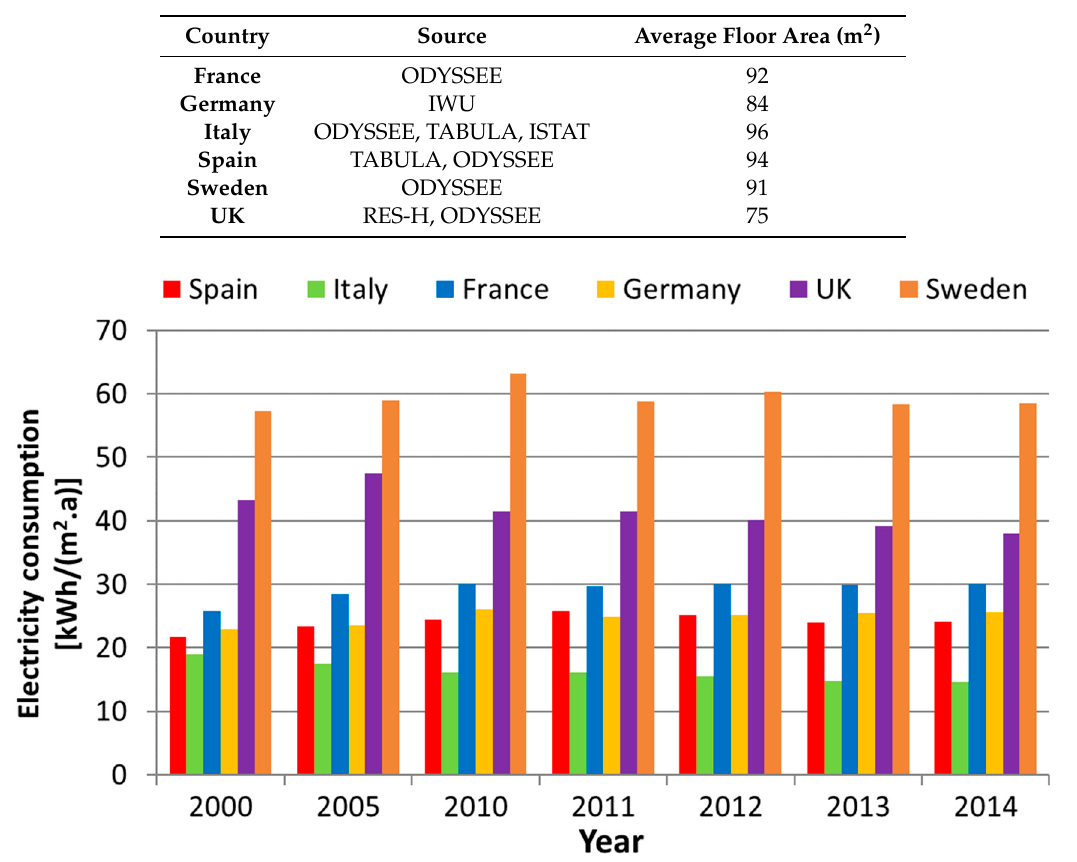
Figure 8. Estimation of the electrical energy consumption for appliances and lighting per square metre by country.